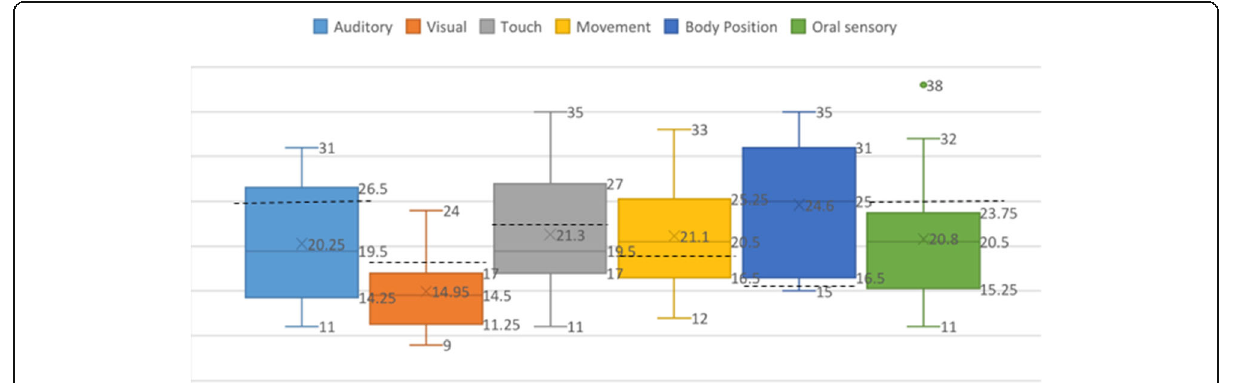
Fig. 2 Box plot showing sensory processing in the sensory systems in children with SCP